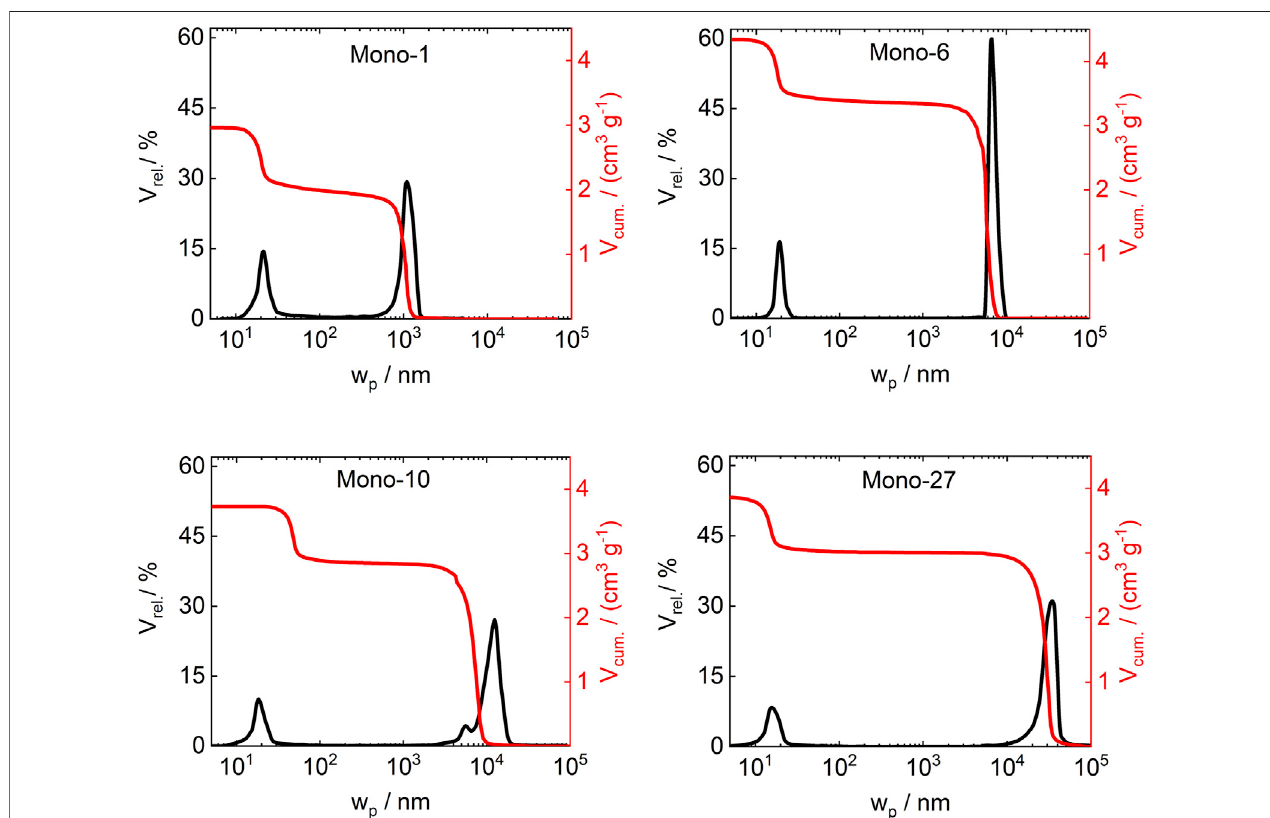
FIGURE 1 | Pore width distributions and contribution of the hierarchical arrangement of macropores and mesopores for HSM samples Mono-1 to Mono-27 analyzed via MIP.